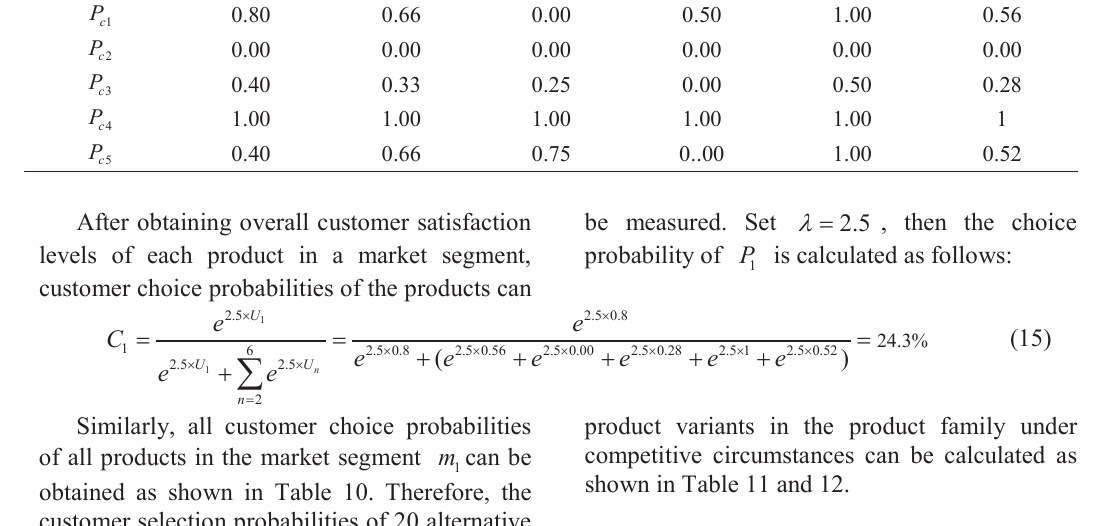
Table 9. Customer satisfaction levels of all the products in market segment